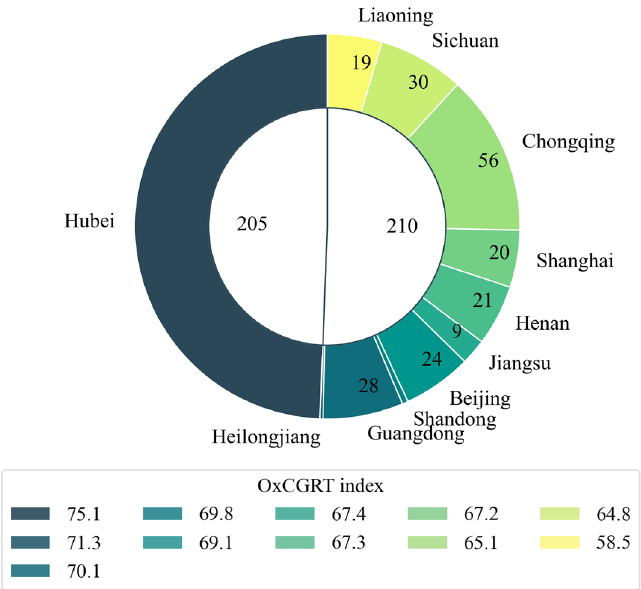
Figure 2. Distribution of subjects from different Chinese provinces. Color coding indicates the average values of the OxCGRT index for the provinces.